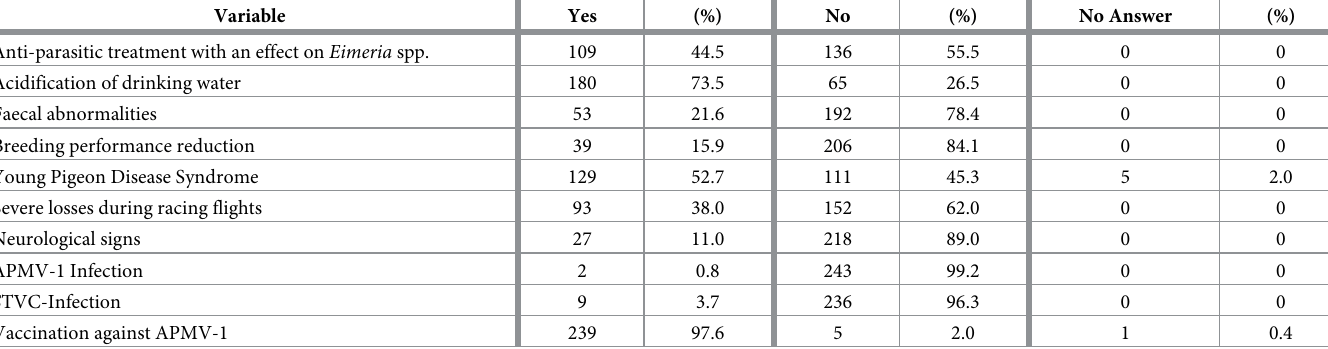
Table 2. Results of the questionnaire of 245 racing pigeon breeders in the period between 2012 and 2016.